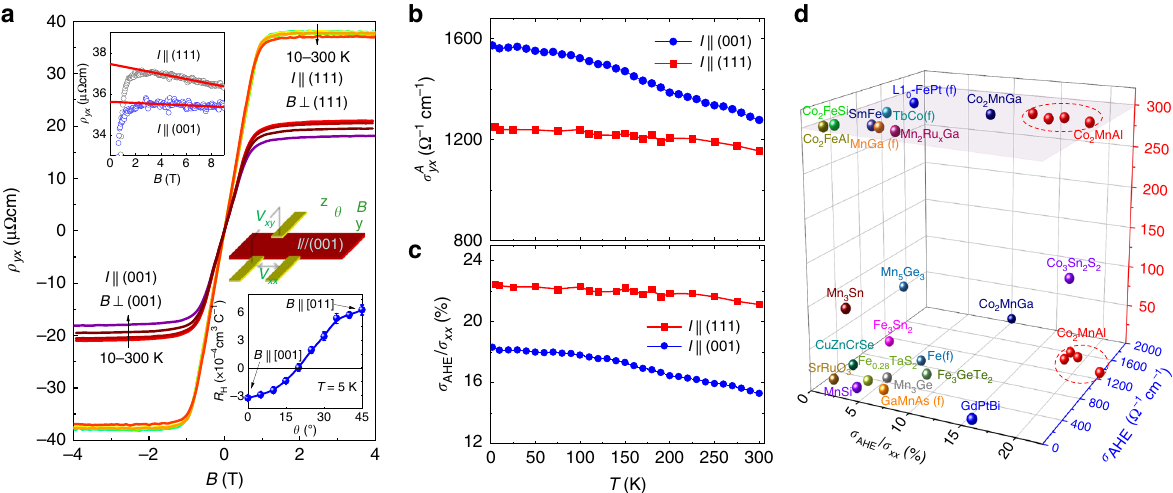
0 Fig. 2 The anomalous Hall effect measurement. a Magnetic fi eld-dependent Hall resistivity ( ρ xy ) at various temperatures for two Co 2 MnAl samples with different orientations. One sample was measured with I ∥ (001) plane and B ⊥ (001) and the other with I ∥ (111) and B ⊥ (111). Left inset: ρ xy vs. B at 300 K, with the data for I ∥ (001) being offset for clarity. Bottom right inset, Hall coef fi cient R H as a function of the orientation angle of magnetization for the sample with I ∥ (001). The middle right inset shows the experimental setup for the angular-dependent Hall effect measurements. b Temperature dependence of anomalous Hall conductivity (AHC) ( σ A yx ) for the samples shown in a . c The temperature dependence of tan Θ H ¼ σ A yx = σ xx at 2 T [ Θ H , anomalous Hall angle (AHA)]. d Comparison of AHC and tan Θ H between Co 2 MnAl and other magnetic conductors; “ f ” refers to thin fi lm materials. Co 2 MnAl exhibits both large AHA and large AHC in a wide temperature range. In addition to the data collected on the samples shown in a , we have also included the data measured on another two additional Co 2 MnAl samples with I ∥ (001) and I ∥ (010) in this fi gure.The AHC and AHA data of other cited magnetic materials and the related references are given in Supplementary Table